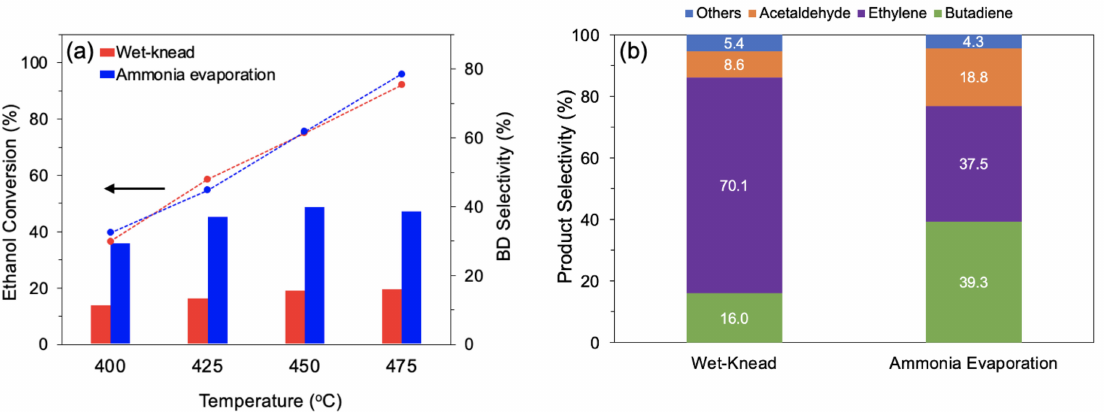
Figure 8. Comparison of MgO-SiO 2 -4 prepared by wet-kneading and ammonia evaporation ( a ) ethanol conversion and butadiene selectivity at various temperatures and ( b ) product selec- tivity at 475 ◦ C. Reaction conditions: 0.1 g catalyst, 1.5 g glass beads, 55 mL/min He, 400 µ L/h ethanol (11.6 vol% ethanol), and TOS = 4